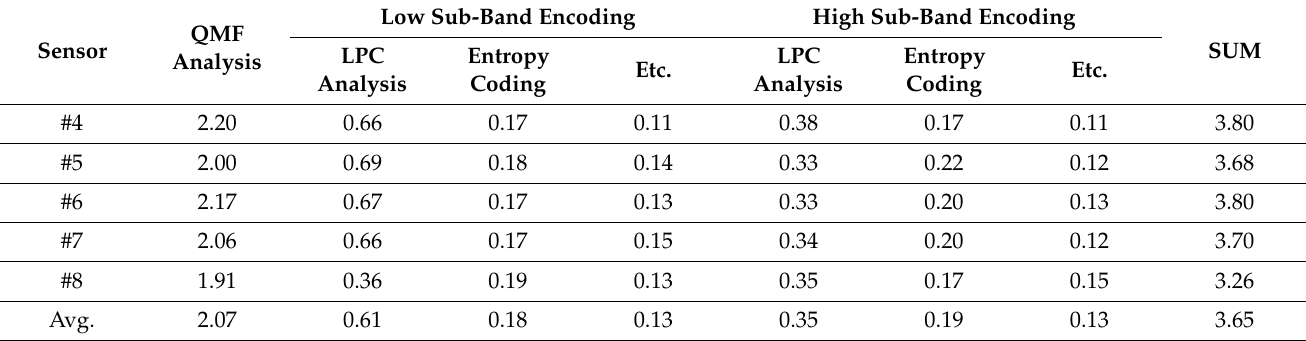
Table 5. Encoding processing time(s) of each processing block of the proposed